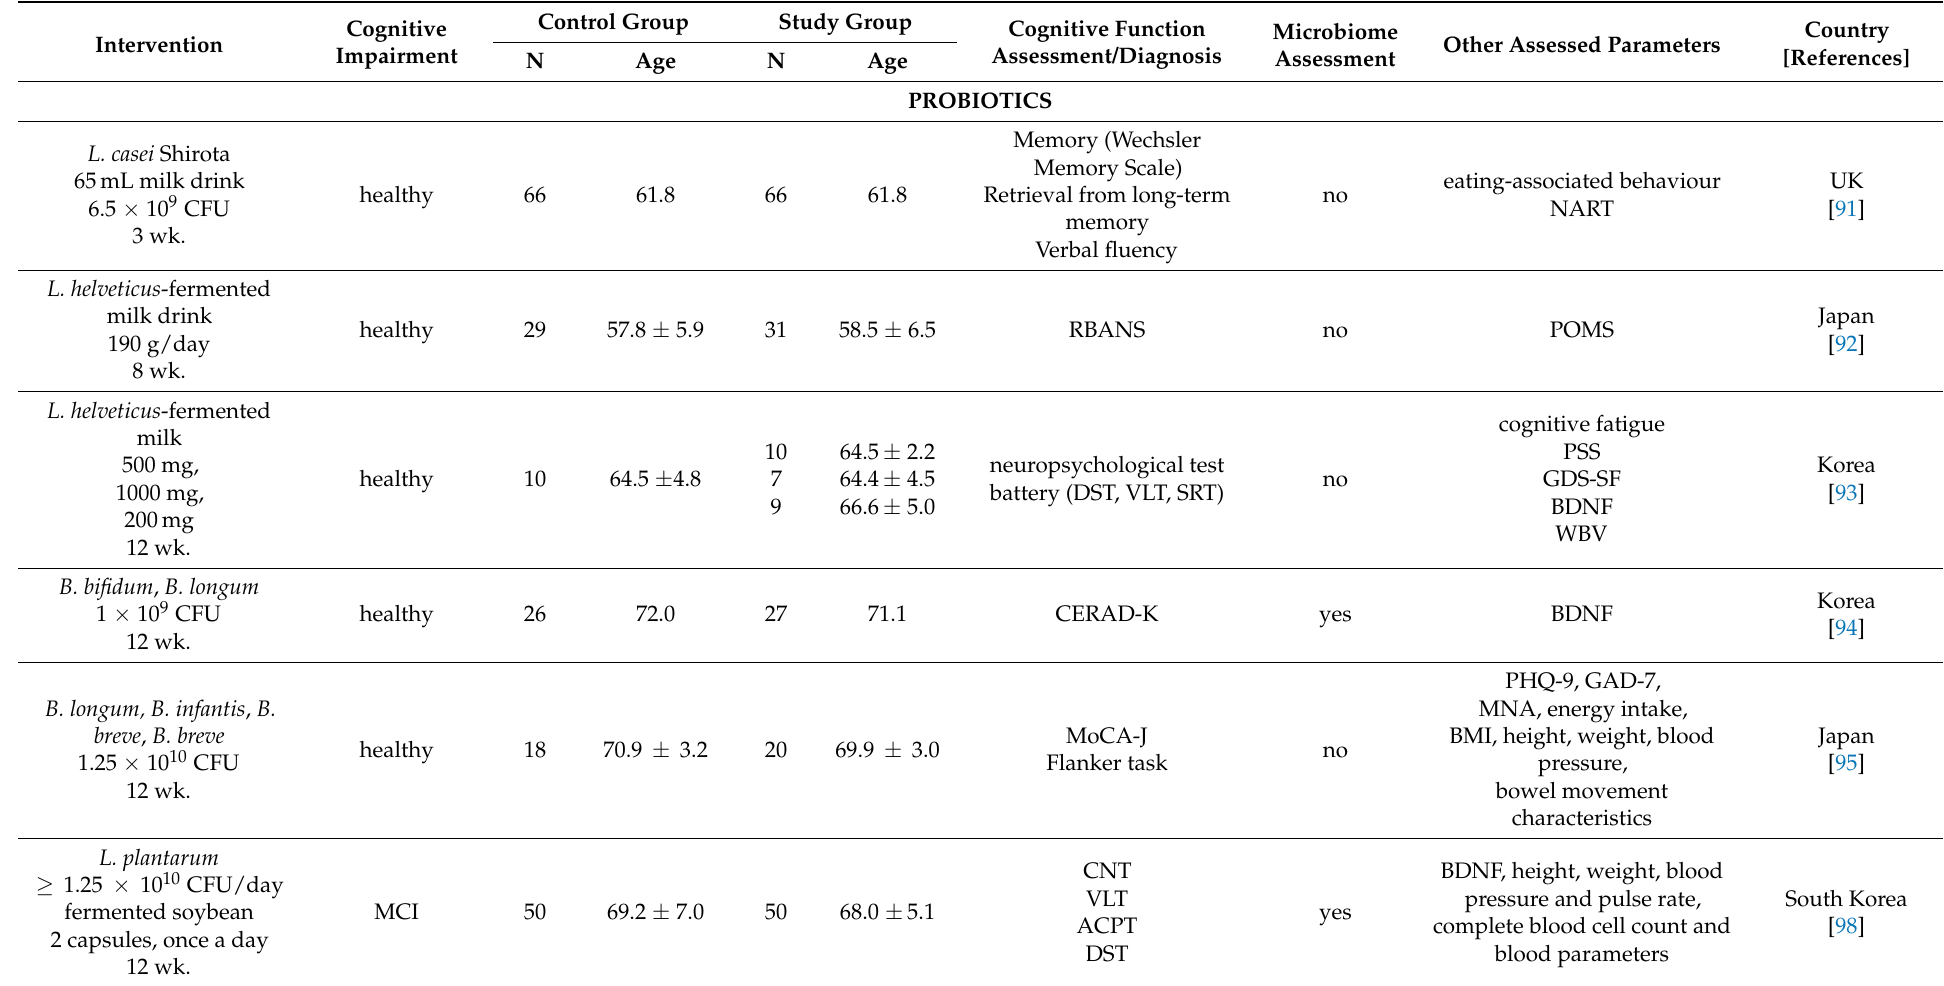
Table 5. Methodological issues of randomized controlled trials (RCT) studies about probiotic, prebiotic, and synbiotic intervention on cognition